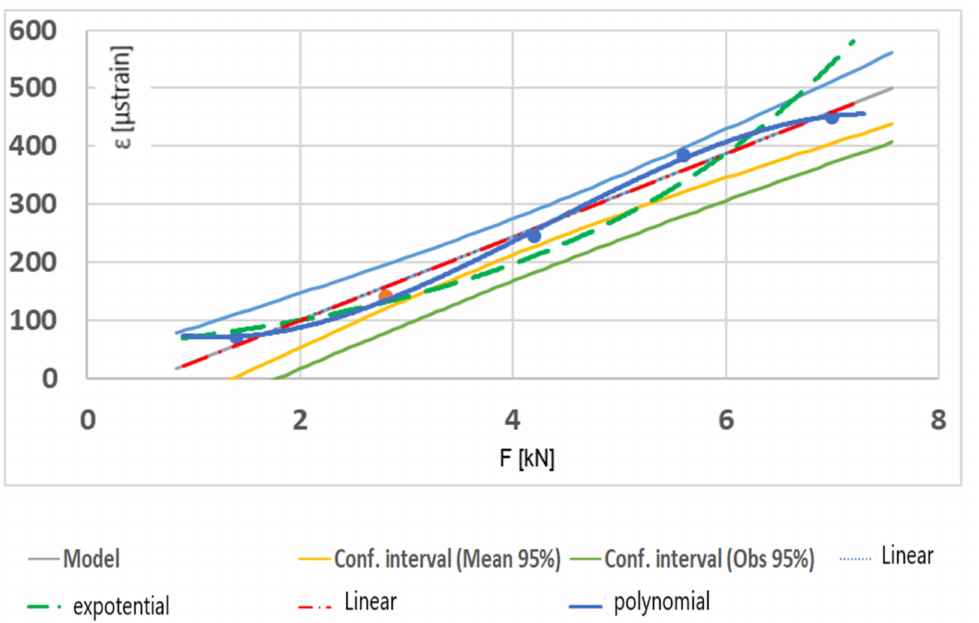
Figure 10. Geogrid strain depending on static